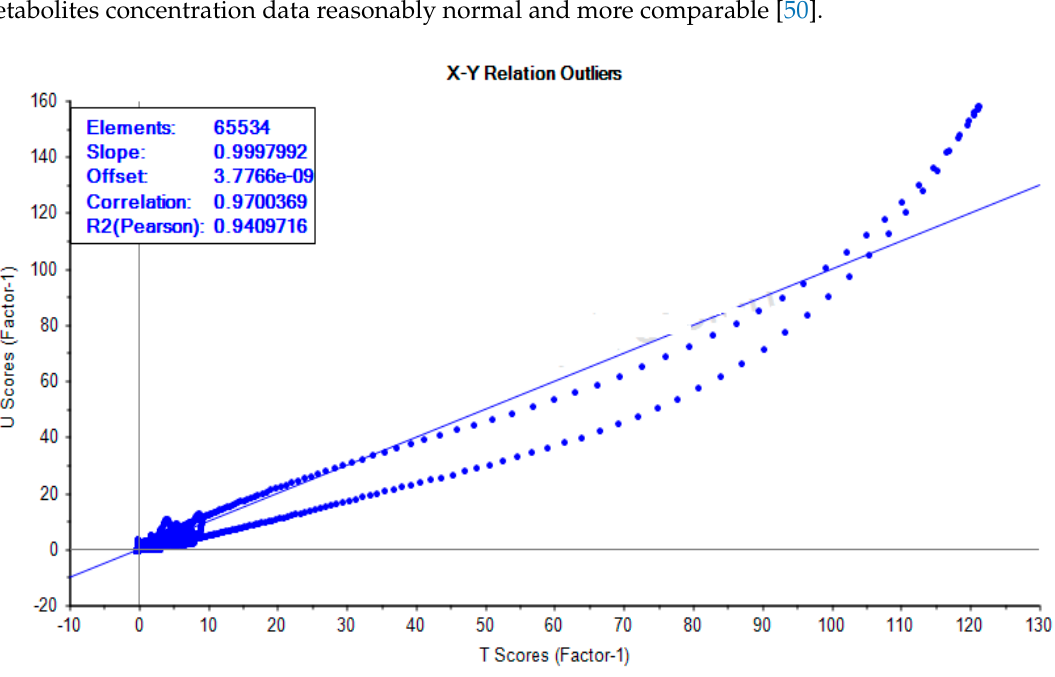
Figure 6. Outliers plot of U-scores vs. T-scores of the H-NMR spectra of honeys (HA-HJ) using Unscrambler ® X 10.5 software.